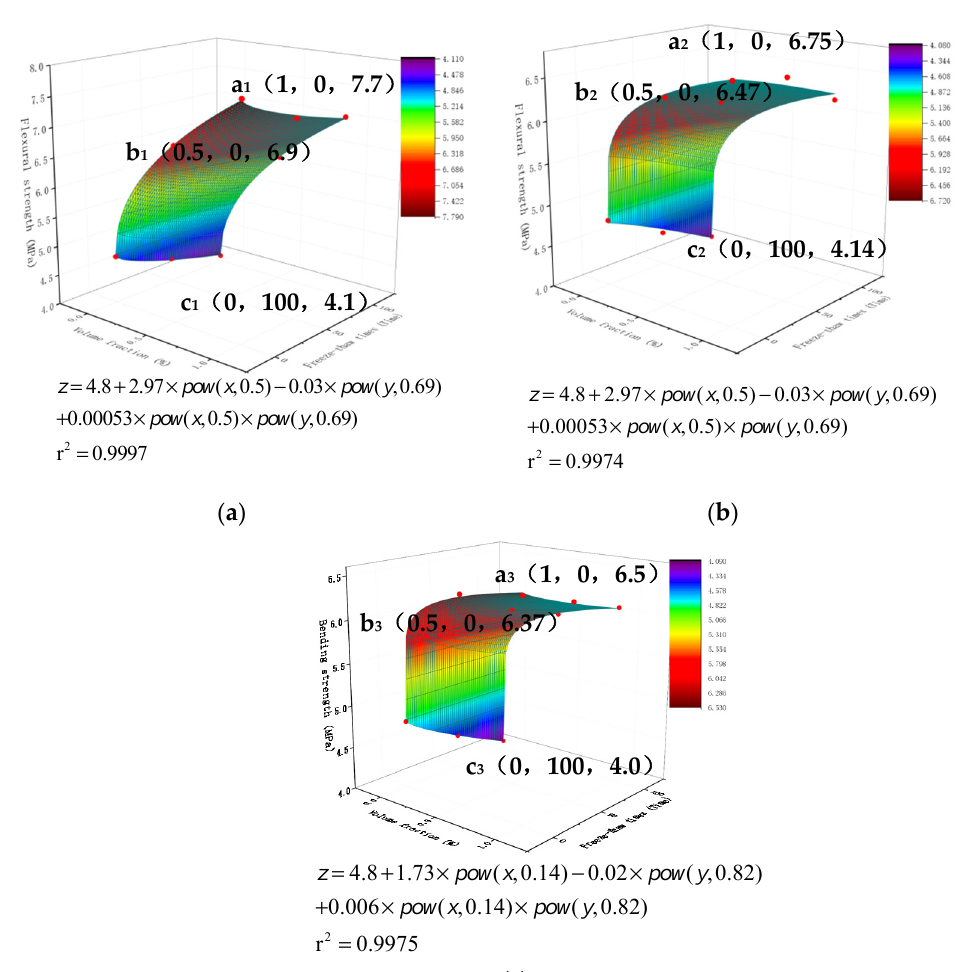
Figure 12. Origin Software Predicted Bending Strength Fitting Surface: ( a ) Carbon fiber; ( b ) Glass fiber; ( c ) PVA fiber. Table 8. Different fiber parameters.